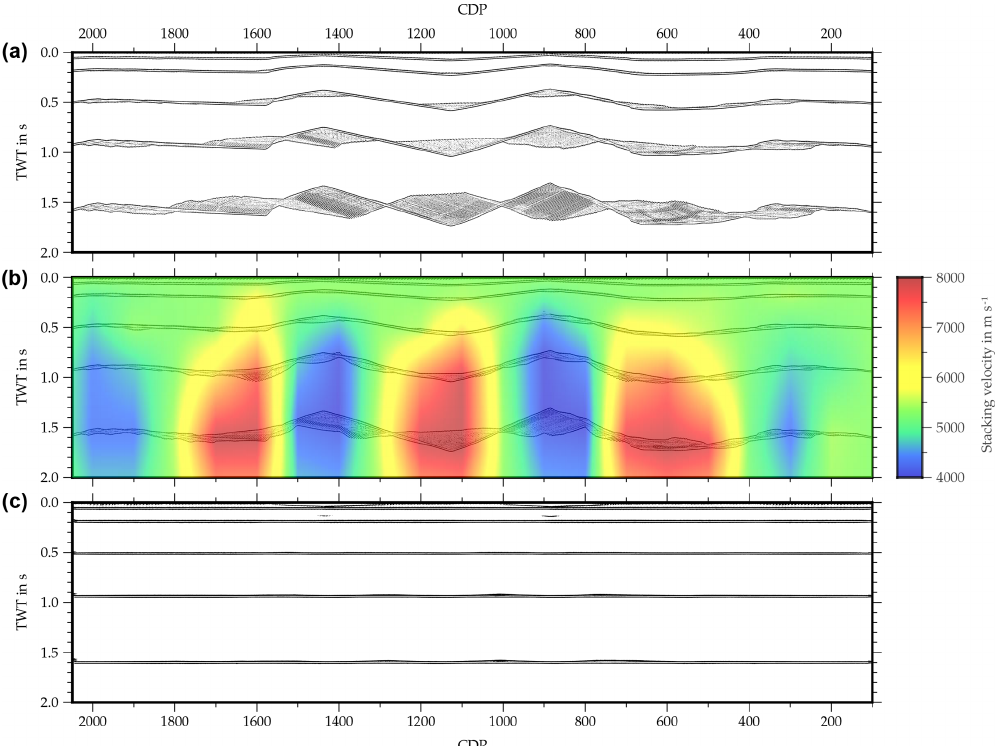
Figure 6. Results of the first synthetic model with reflectors dipping in the cross-line direction. The reflections in the stacked section without cross-dip correction (a) are heavily deformed and smeared. Using the optimum stacking velocities instead of the model velocity (b) reduces the smearing locally, but the reflections remain distorted. After cross-dip correction, the reflections become focused and flattened (c) .